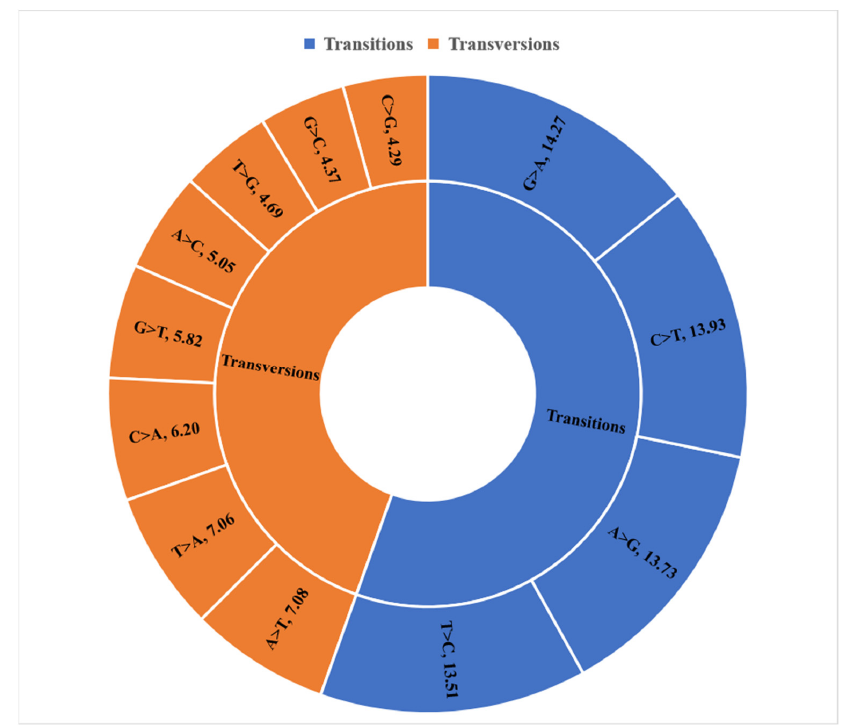
Figure 2. Proportion of SNP markers by transition and transversion polymorphisms.